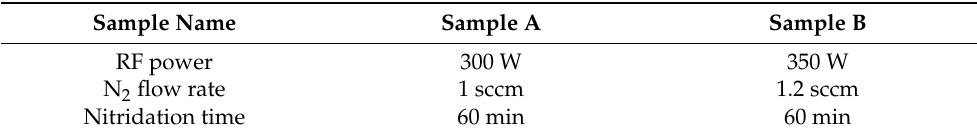
Table 1. Experimental parameters for nitrided Si 3 N 4